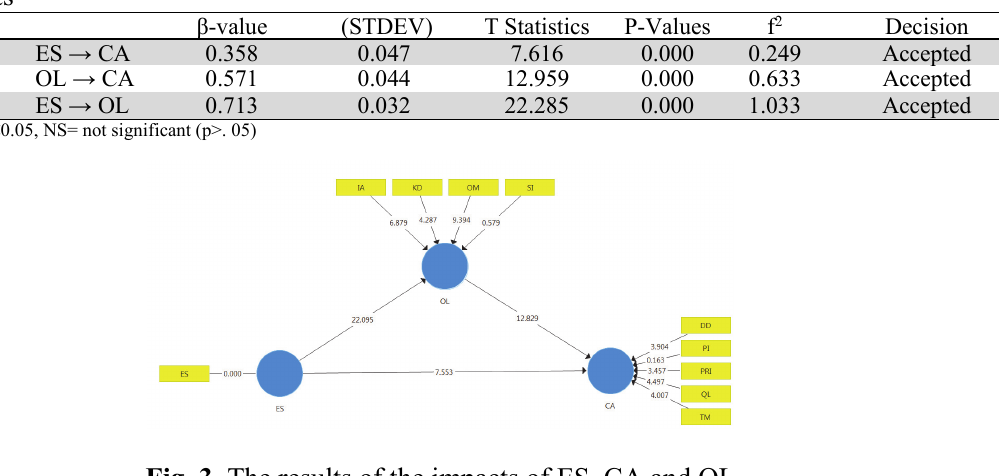
Fig. 3. The results of the impacts of ES, CA and OL